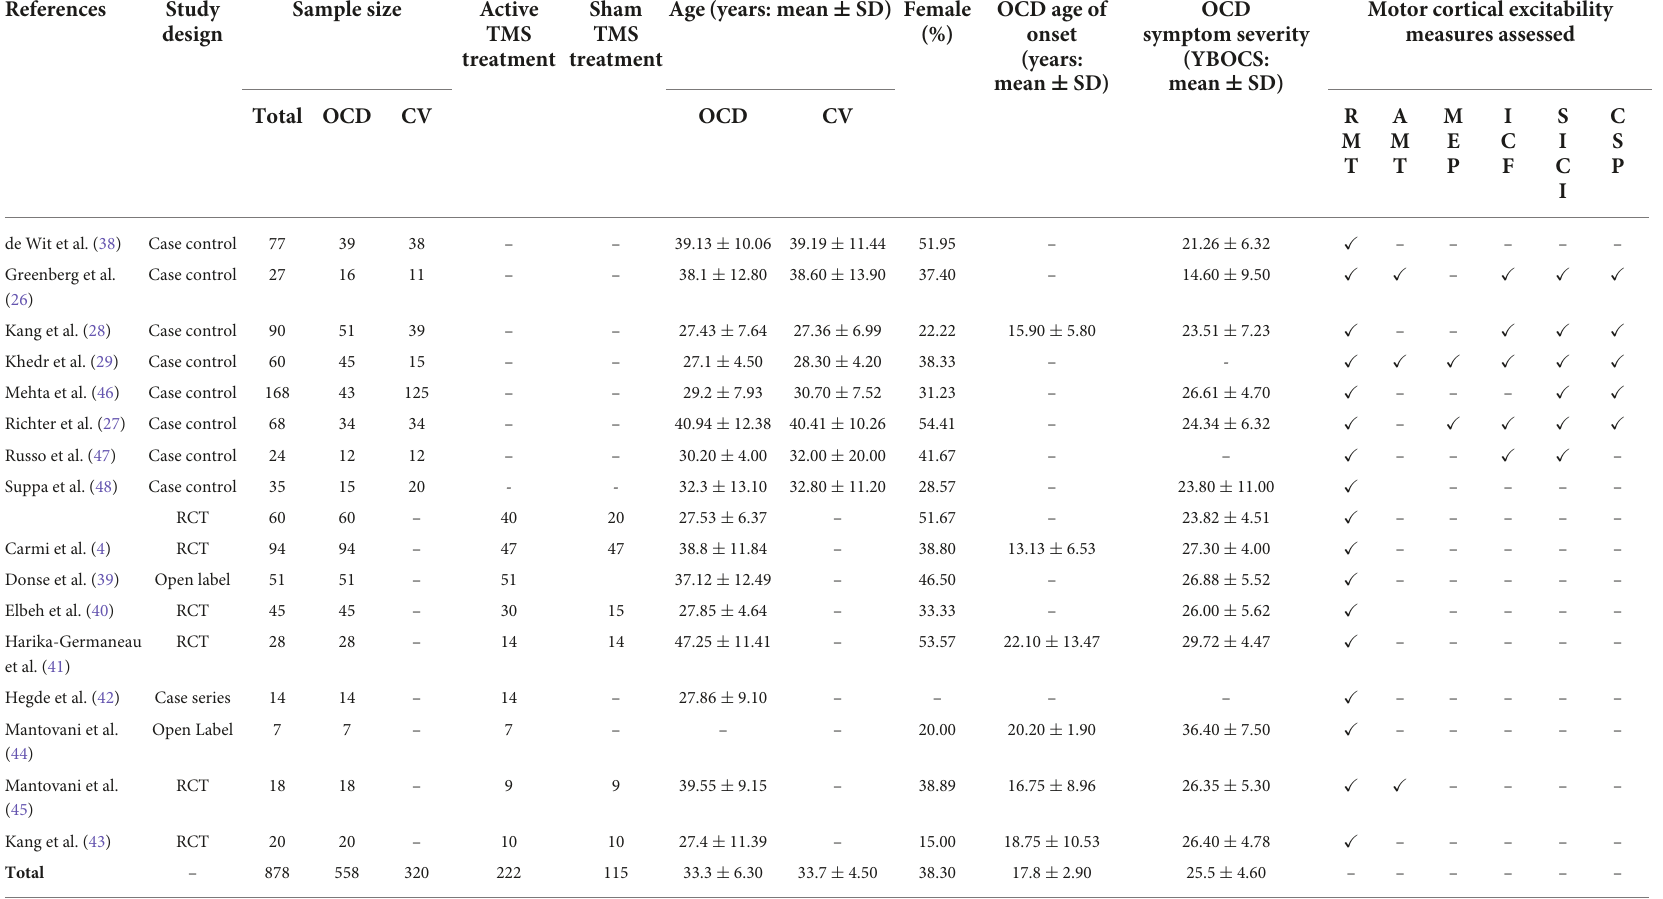
TABLE 1 Summary results of eligible